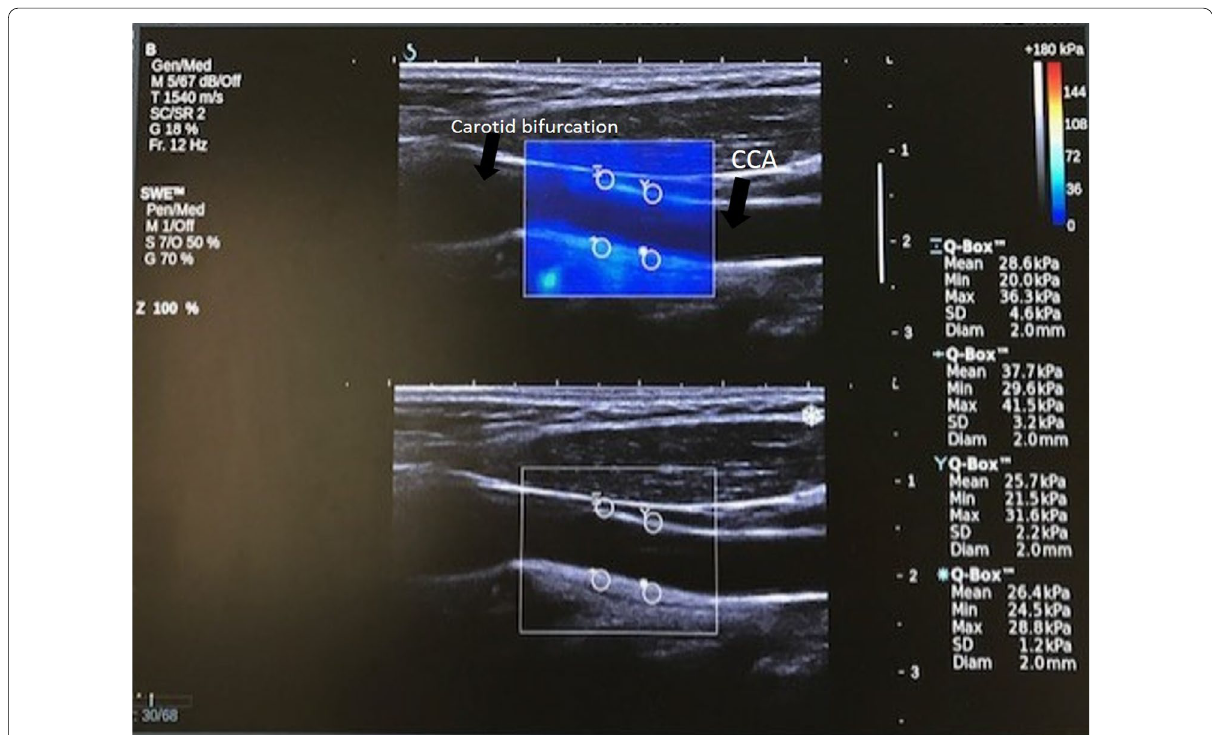
Fig. 5 Different SWE regions of interest (ROIs) over anterior and posterior wall of